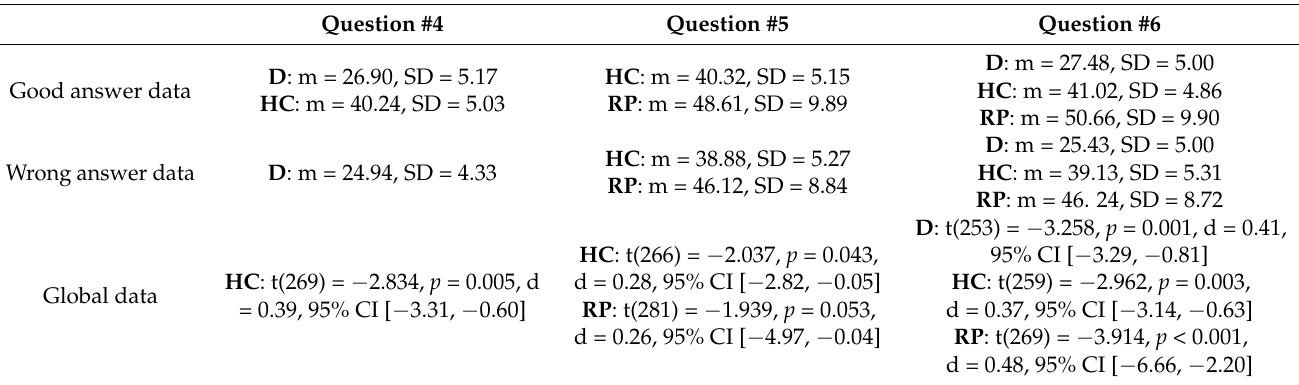
Table 3. First hypothesis data. D: Denial about ABR risk. HC: Health consequences of ABR risk. RP: Risk perception of ABR risk. First Hypothesis: Subjects with Inappropriate Practices Would Have a Lower ABR Risk Perception, Concern and